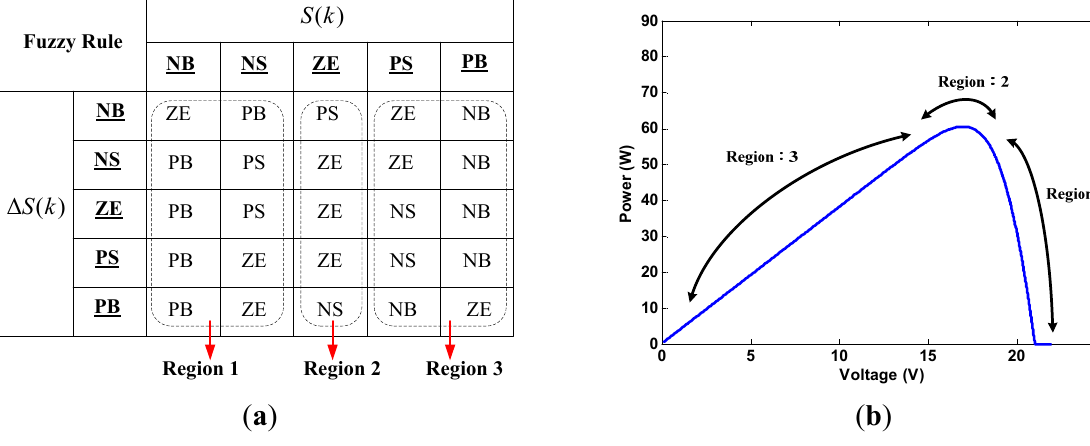
Figure 6. Fuzzy rules for P-V slope and changes of slope as the